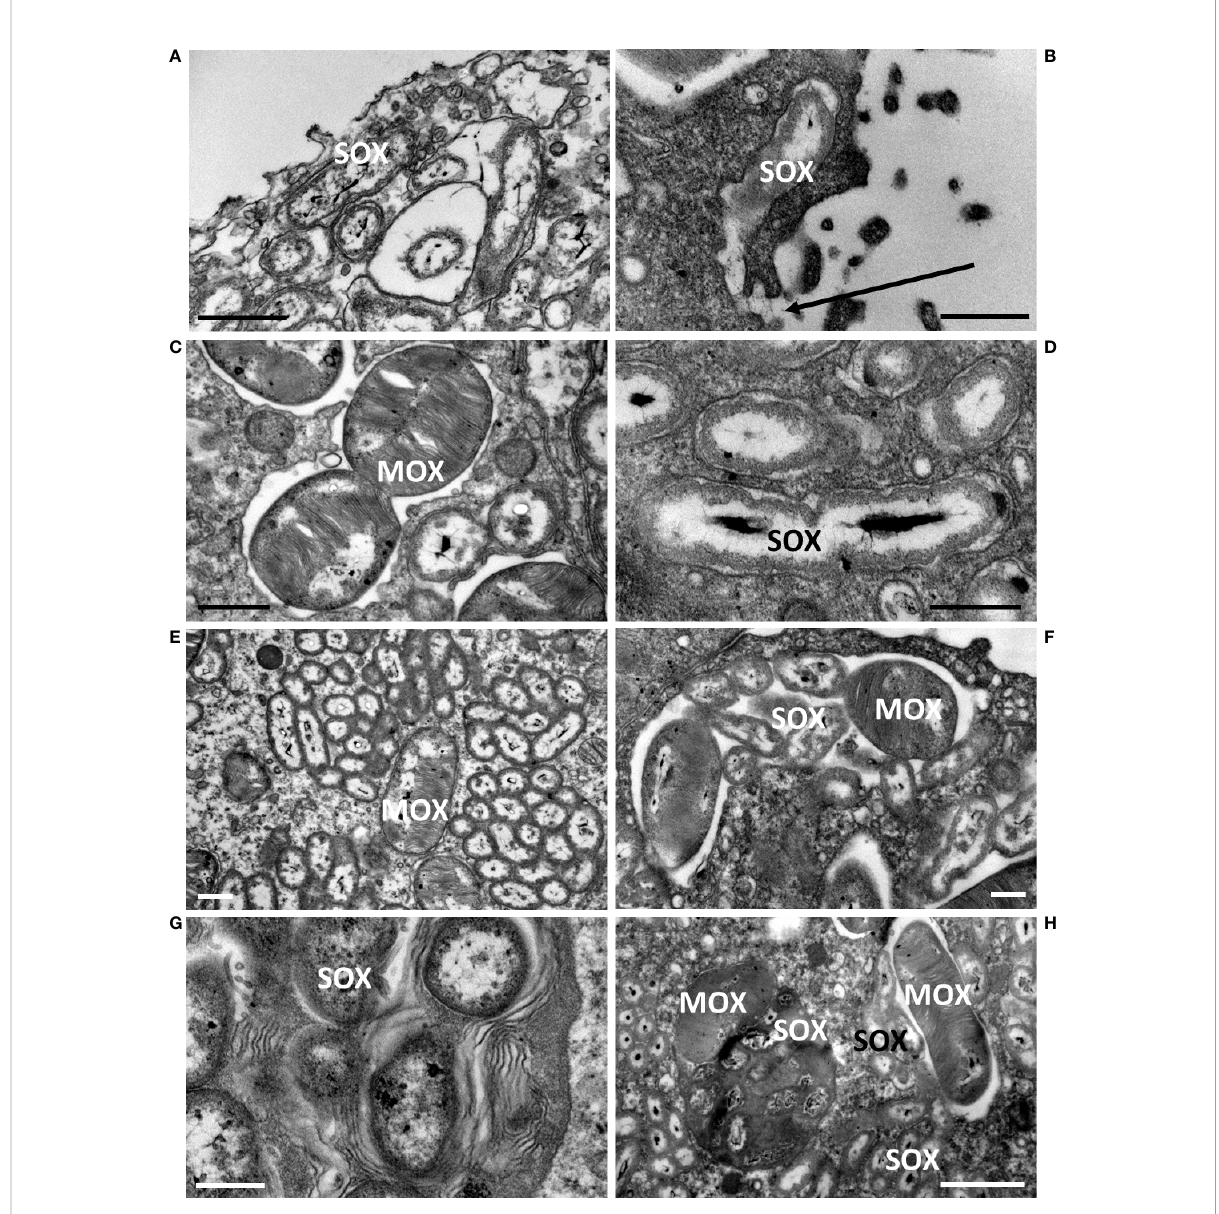
FIGURE 4 Close-up details of bacteriocytes in B azoricus from Menez Gwen (left column) and from Lucky Strike (right column), immediately upon recovery, illustrating the four processes (numbered according to the successive processes shown as boxed numbers on Figure 3. (1) (A, B) ,apical endocytosis, (2) (C, D) , symbiont division, (3) (E, F) , symbiont storage, (4) (G, H) , symbiont digestion. In A and B, the apical microvilli and the endocytic vacuoles phagocyte a single bacterium, here a SOX symbiont. A direct connection between the vacuole and the external seawater is visible in (B) , and pointed by an arrow. (C) Division of a MOX symbiont displaying the two daughter bacteria. (D) Division of a SOX symbiont with the two daughter nucleoids appearing clearly segregated, while they were still not separated by a bacterial wall. (E, F) Vacuoles contain either SOX or MOX in (B) azoricus from Menez Gwen (E) , but both types of symbionts share the same vacuole at Lucky Strike (F) . (G, H) the most basal vacuoles contain onion-peel membranes (G) and/or degraded SOX/MOX symbionts (H) indicating they are putative lysosomes digesting symbionts. Scale bars represent 0.5 µm in (B, D, F, G) ; 1 µm in (C – E) and 2 µm in (H)